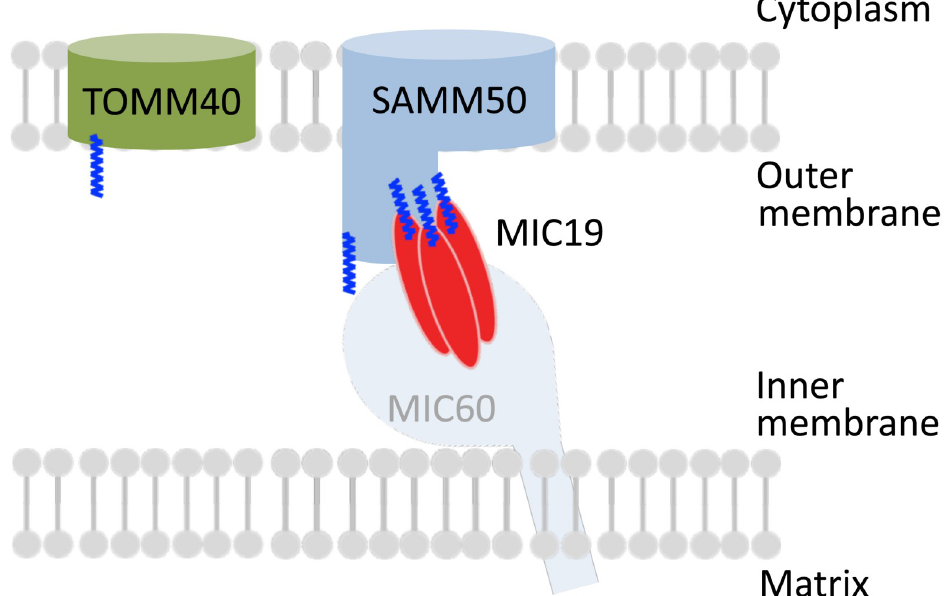
Fig 12. Schematic representation of the intracellular localization and protein-protein interactions of SAMM50, TOMM40, and MIC19. SAMM50, TOMM40, MIC19, and MIC25 were cotranslationally N -myristoylated in the cytoplasm. These proteins are transported into the intermembrane space of mitochondria through the TOM complex. For SAMM50 and MIC19, protein N -myristoylation is required for mitochondrial targeting. An oligomeric form of N - myristoylated MIC19 seems to associate with N -myristoylated SAMM50. Protein N -myristoylation of MIC19 is required for the binding of MIC19 to SAMM50.